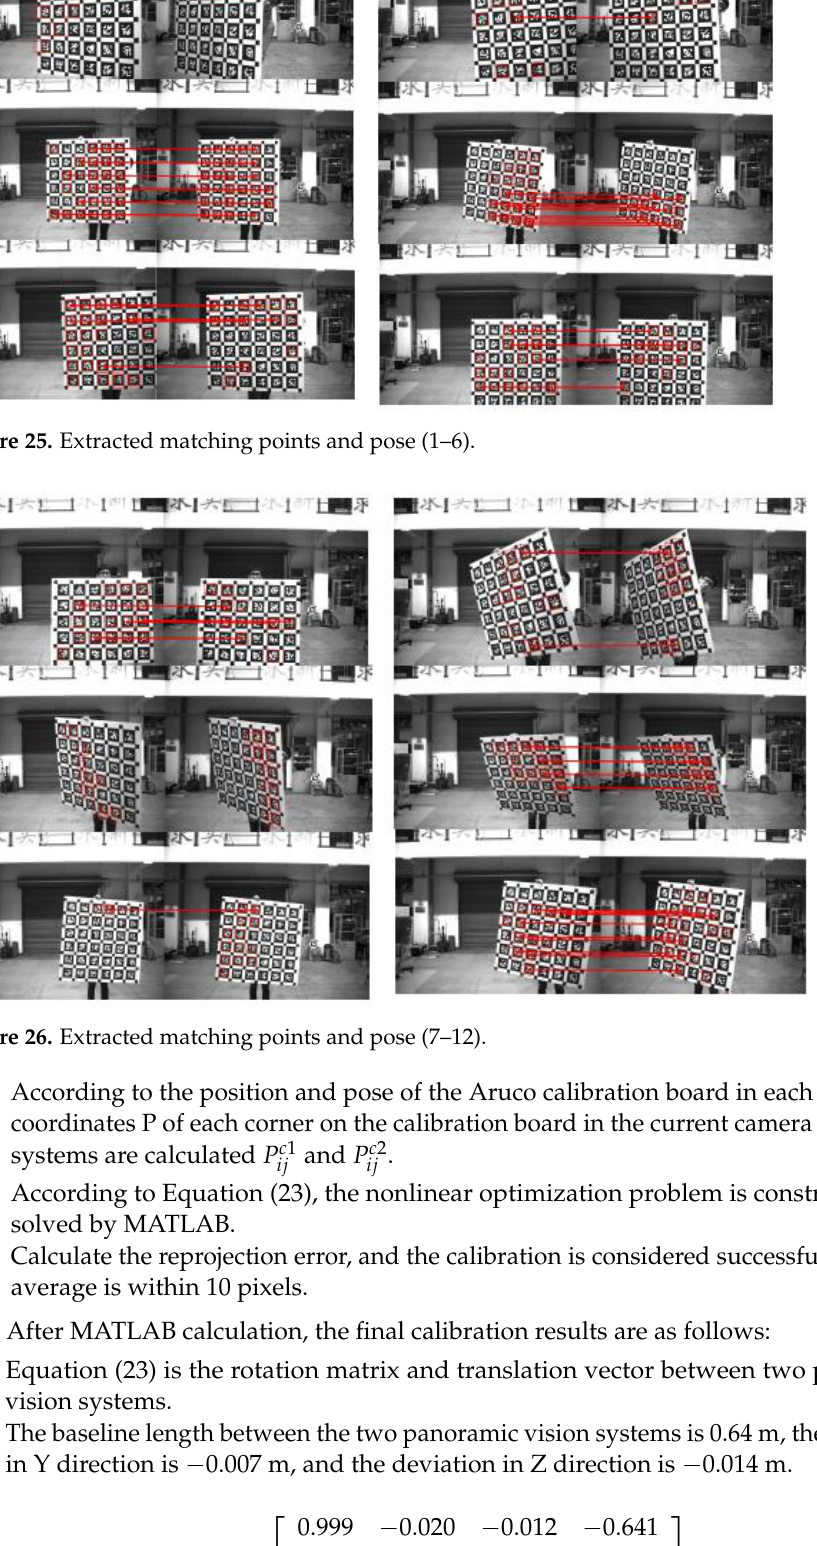
Figure 24. Twelve pairs of images collected at the same time (capture).